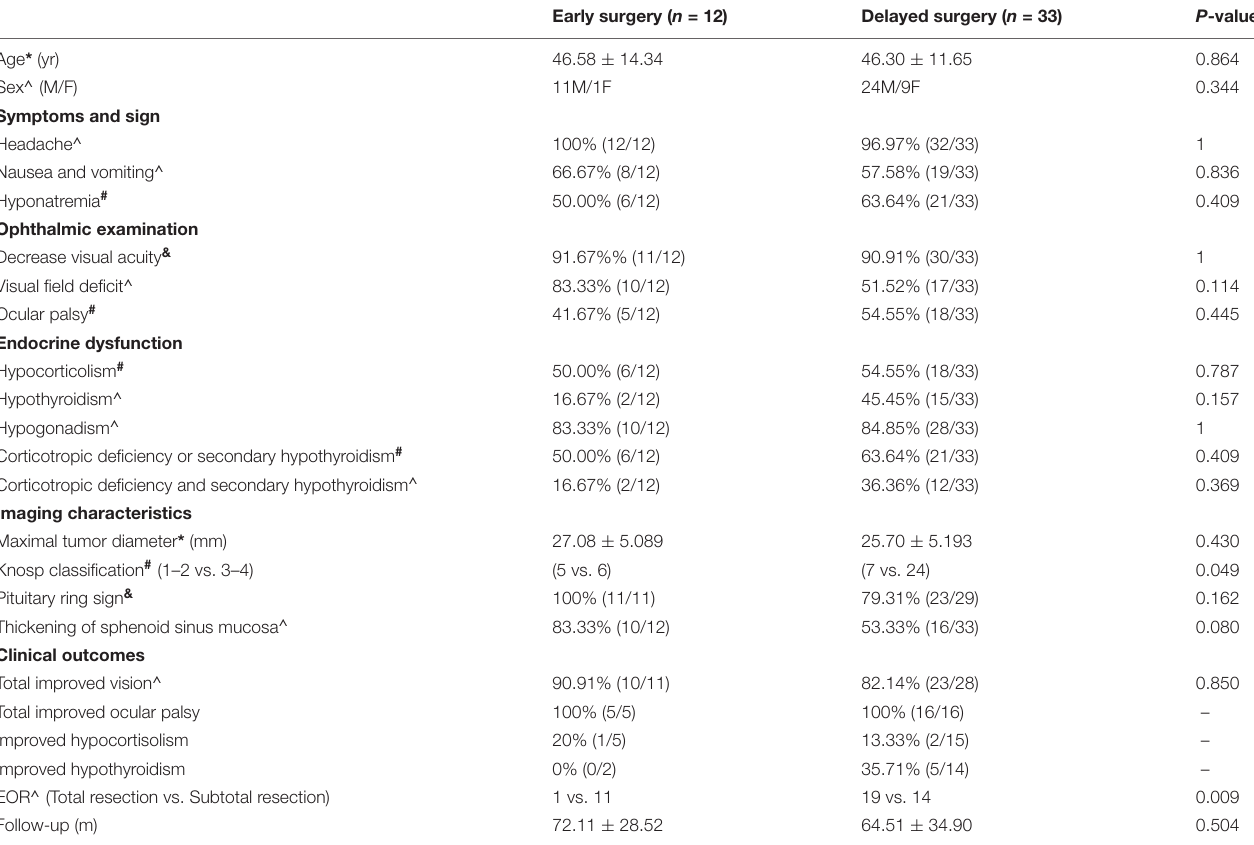
TABLE 2 | Comparison of clinical presentation and outcomes of ischemic PA between early and delayed surgery